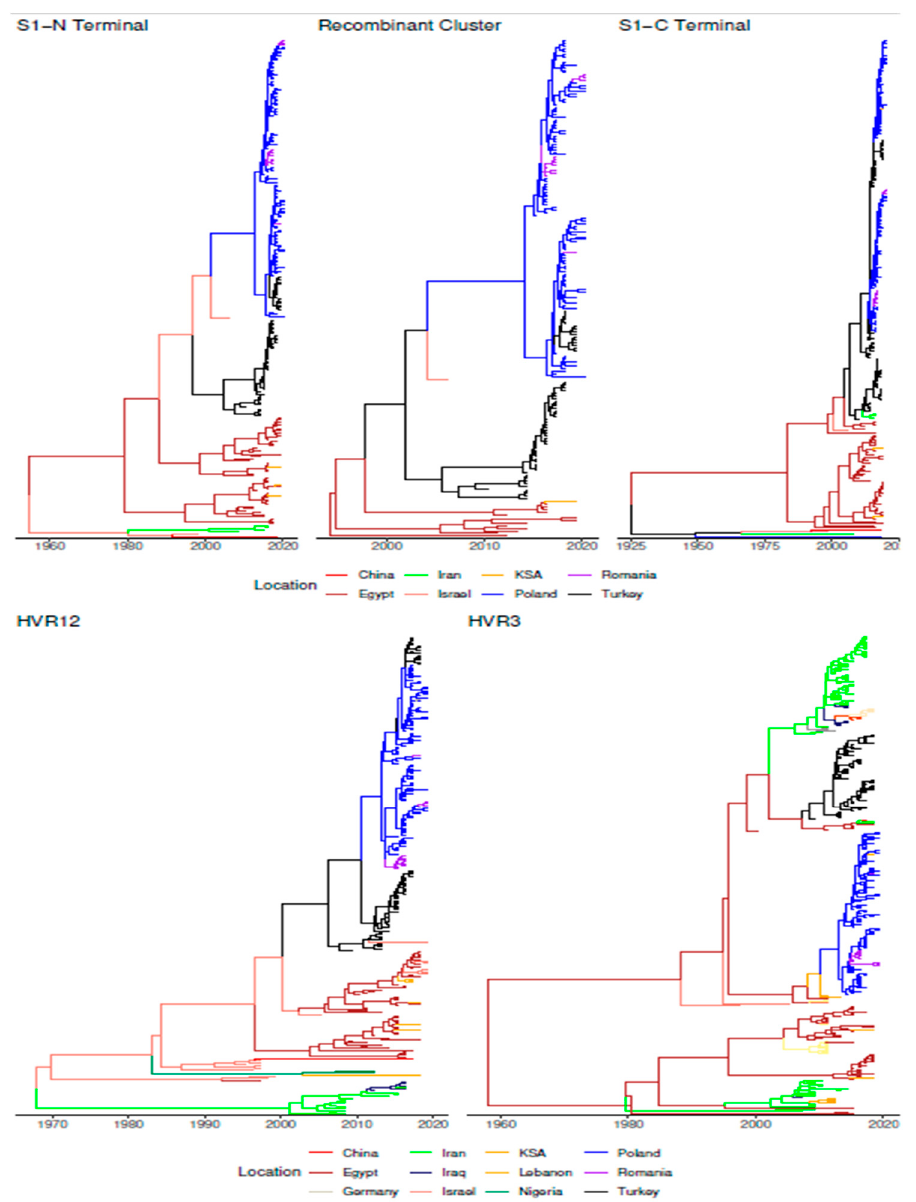
Figure 4. Time calibrated phylogenetic trees obtained for the different datasets runs are reported. The tree branches have been colour-coded according to the location predicted with the highest posterior probability.